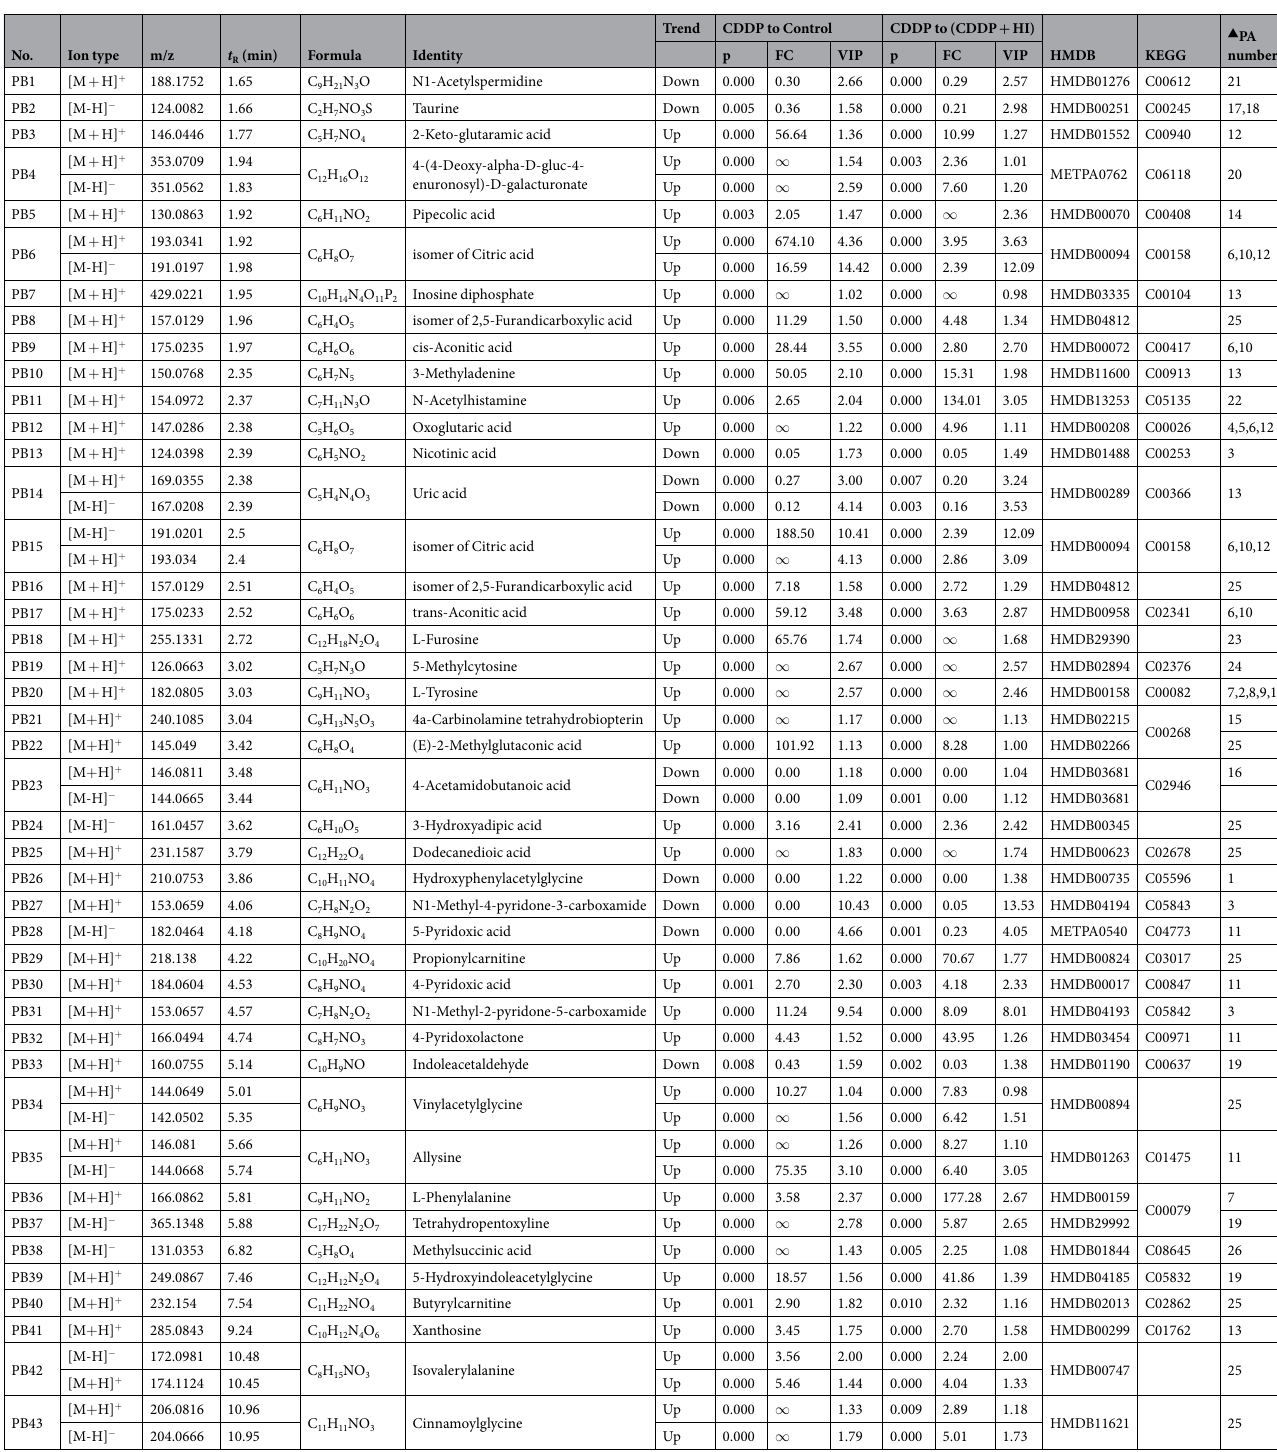
Table 1. Urine endogenous metabolites identified as potential biomarkers for the protection of HuangQi Injection from CDDP-induced toxicity. ▲ PA1: Tyrosine metabolism; PA2: Ubiquinone and other terpenoid-quinone biosynthesis; PA3: Nicotinate and nicotinamide metabolism; PA4: D-Glutamine and D-glutamate metabolism; PA5: Butanoate metabolism; PA6: tricarboxylic acid cycle (TCA cycle); PA7: Phenylalanine, tyrosine and tryptophan biosynthesis; PA8: Phenylalanine metabolism; PA9: Aminoacyl-tRNA biosynthesis; PA10: Glyoxylate and dicarboxylate metabolism; PA11: Vitamin B6 metabolism; PA12: Alanine, aspartate and glutamate metabolism; PA13: Purine metabolism; PA14: Lysine degradation; PA15: Folate biosynthesis; PA16: Arginine and proline metabolism; PA17: Taurine and hypotaurine metabolism; PA18: Primary bile acid biosynthesis; PA19: Tryptophan metabolism; PA20: Pentose and glucuronate interconversions; PA21: polyamine metabolism; PA22: Histidine metabolism; PA23: lysine metabolism; PA24: Pyrimidine metabolism; PA25: Fatty acid metabolism; PA26: isoleucine